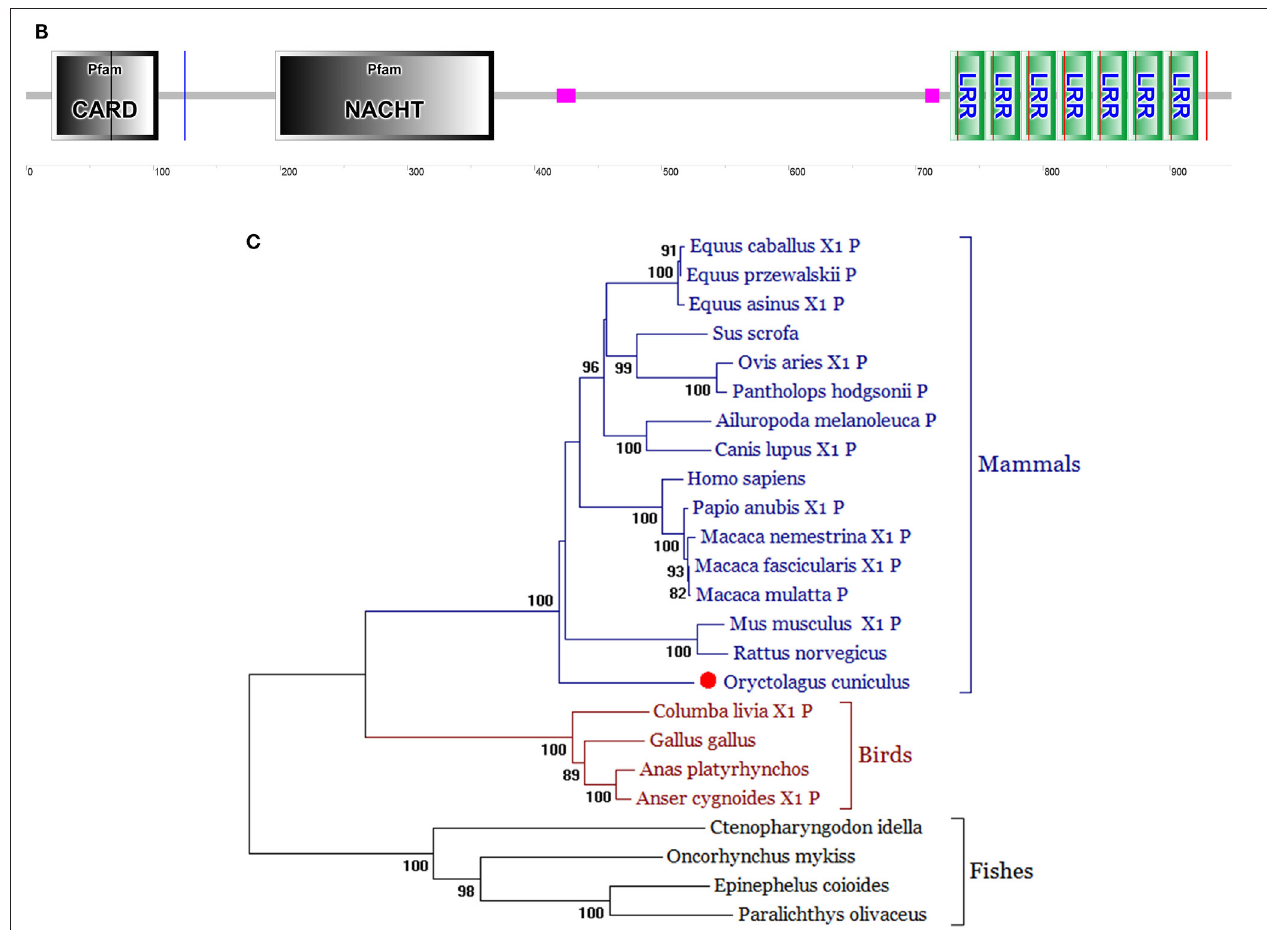
FigUre 1 | Sequence analysis of rabbit nucleotide-binding oligomerization domain 1 (rNOD1). (a) Alignment of amino acid sequence in Oryctolagus curiculus (MF069503), Homo sapiens (NP_006083.1), Mus musculus (NP_ 766317.1), and Sus scrofa (NP_001107749.1) NOD1. Alignment was performed using Clustal X and edited with Boxshade. Black shading indicates amino acid identity; gray shading indicates similarity (50% threshold). The caspase activation and recruitment domain (CARD), NACHT, and leucine-rich repeat (LRR) domains were indicated in this figure. (B) Protein motifs of rNOD1 were analyzed using sample modular architecture research tool (SMART). (c) A phylogenic tree based on rNOD1 between O. curiculus and other species. A neighbor-joining tree was generated using MEGA 5.0, and a 1,000-bootstrap analysis was performed. The sequences used were: Equus caballus NOD1, XP_001499616.1; Equus przewalskii NOD1, XP_008521180.1; Equus asinus NOD1, XP_014696539.1; Sus scrofa NOD1, NP_001107749.1; Ovis aries NOD1, XP_ 004007979.1; Pantholops hodgsonii NOD1, XP_005981278.1; Ailuropoda melanoleuca NOD1, XP_002919315.1; Canis lupus NOD1, XP_013974566.1; Homo sapiens NOD1, NP_006083.1; Papio anubis